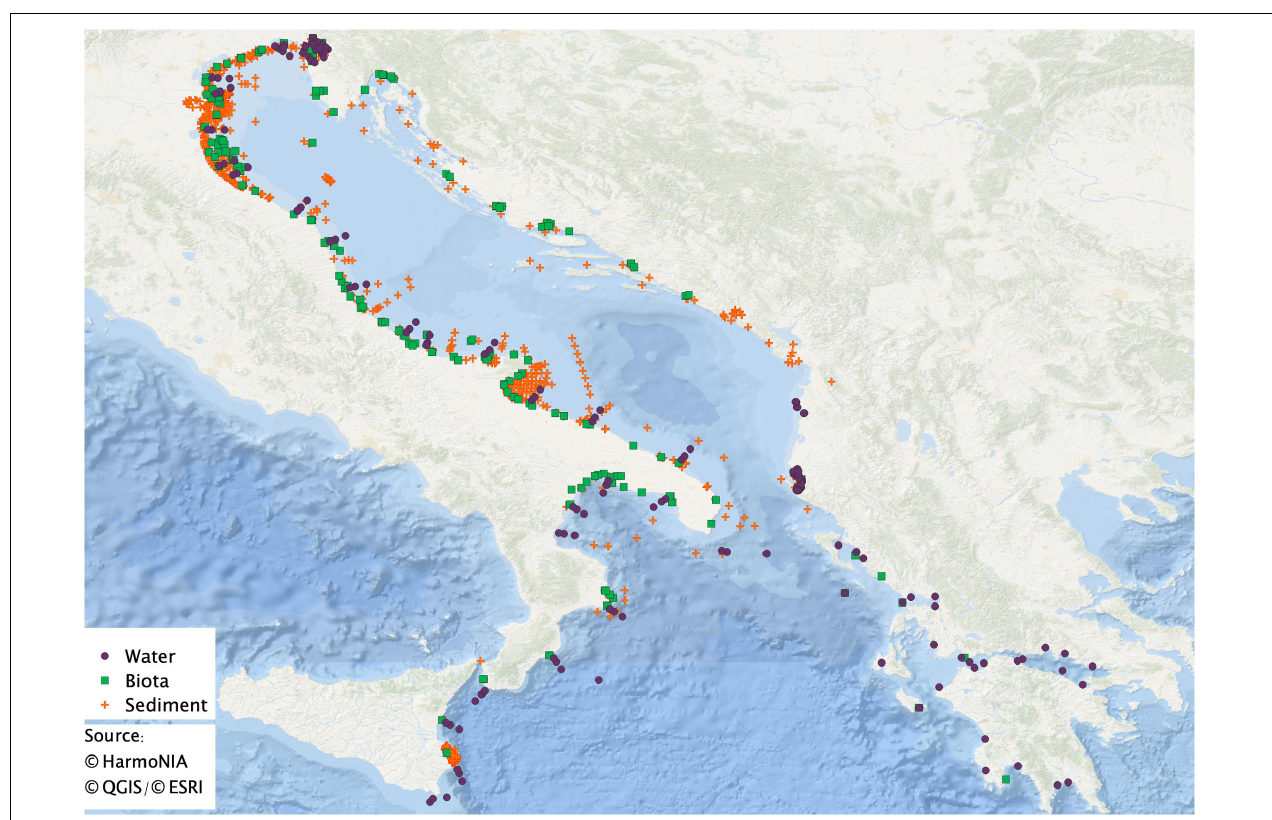
FIGURE 1 | Map of sampling stations in the ADRION area. Data are available for water (violet, dots), biota (green, square), and sediment (orange,